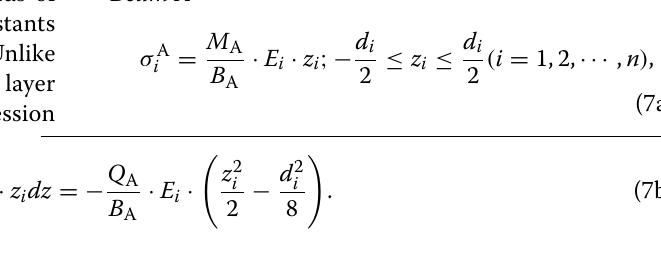
a The value was adjusted by multiplying a scale factor E 0 / E Lit to the parallel-to-grain shear modulus G Lit from literature [11, 12], where E Lit and G Lit are the modulus of elasticity from the literatures b The estimated value obtained from regression analysis c Provisional values given for the regression